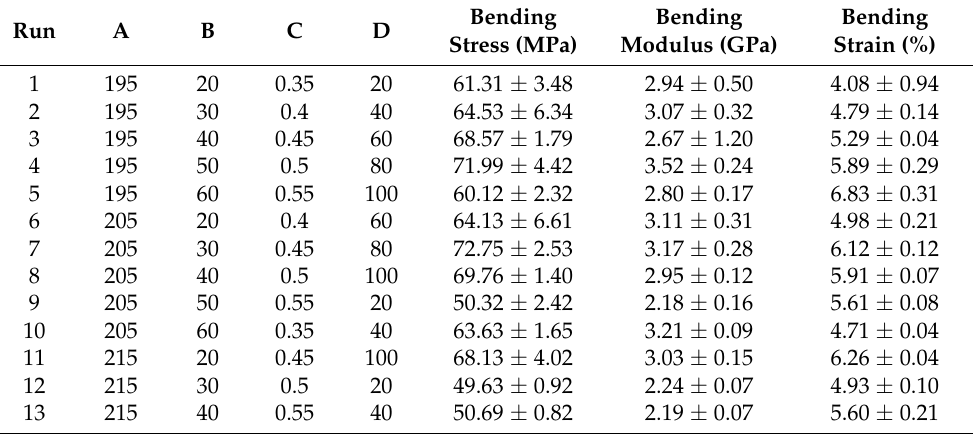
Table 5. Bending experimental results detailed obtained using Taguchi L16 (4 5 ) for